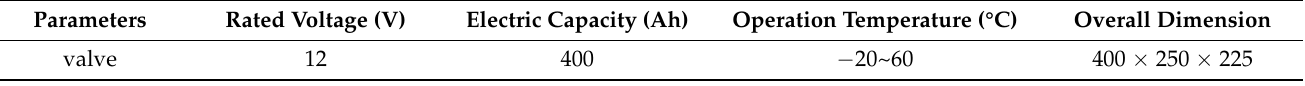
Table 3. Battery main parameter.